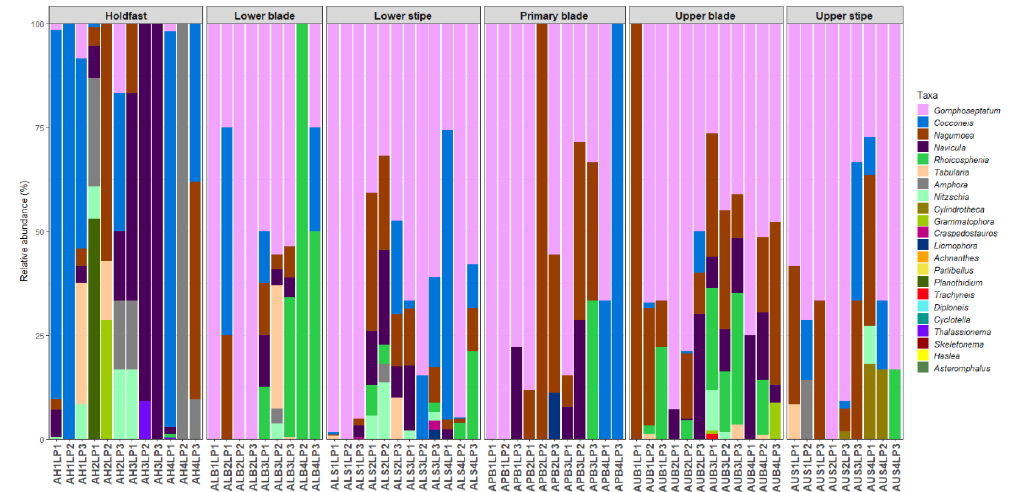
Figure 7. Relative abundance of diatom genera on different parts of adult specimens of Laminaria pallida .